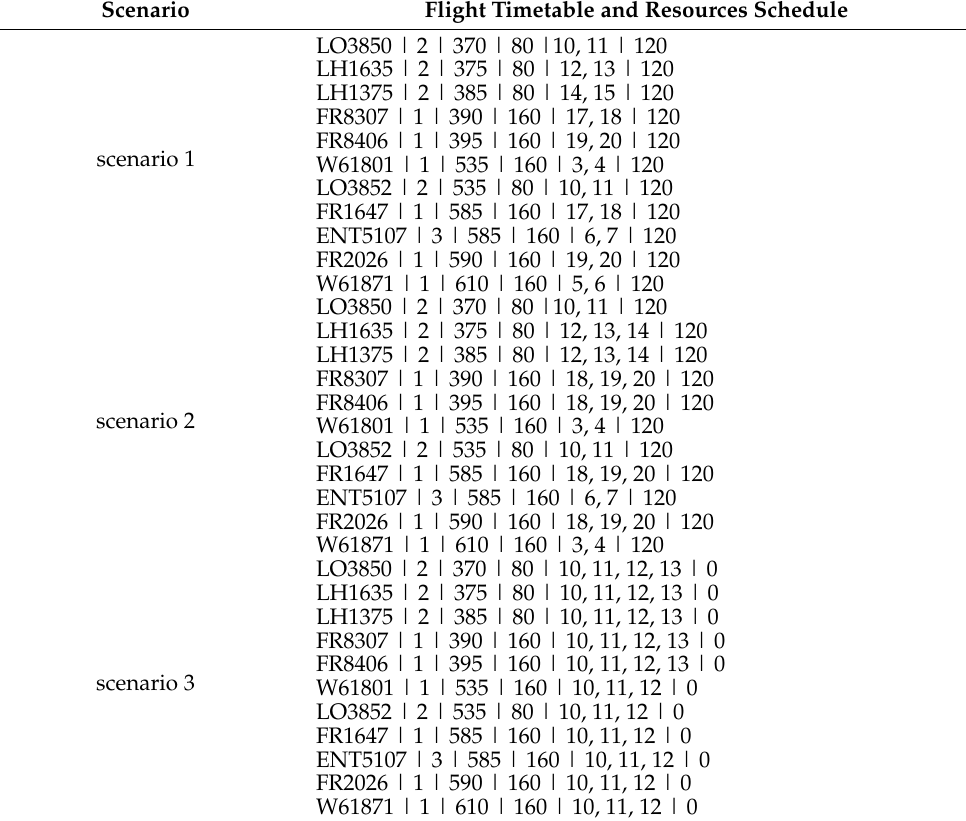
Table 3. Input data summary.